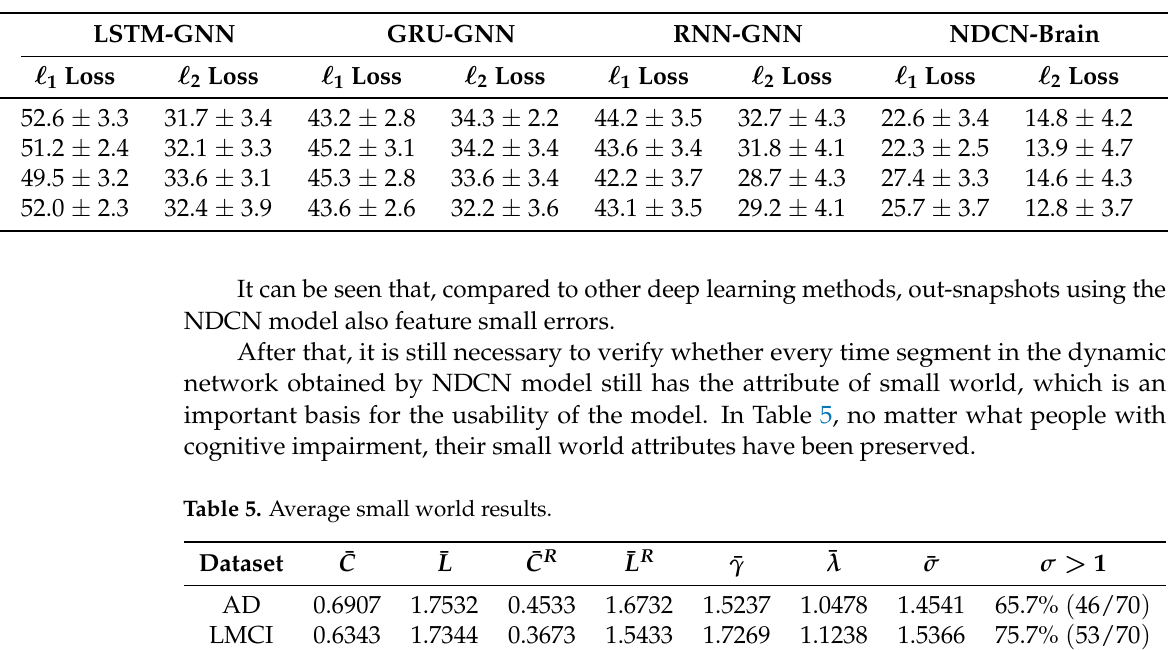
Table 4. The (cid:96) 1 loss and (cid:96) 2 loss comparison results of out-snapshots.